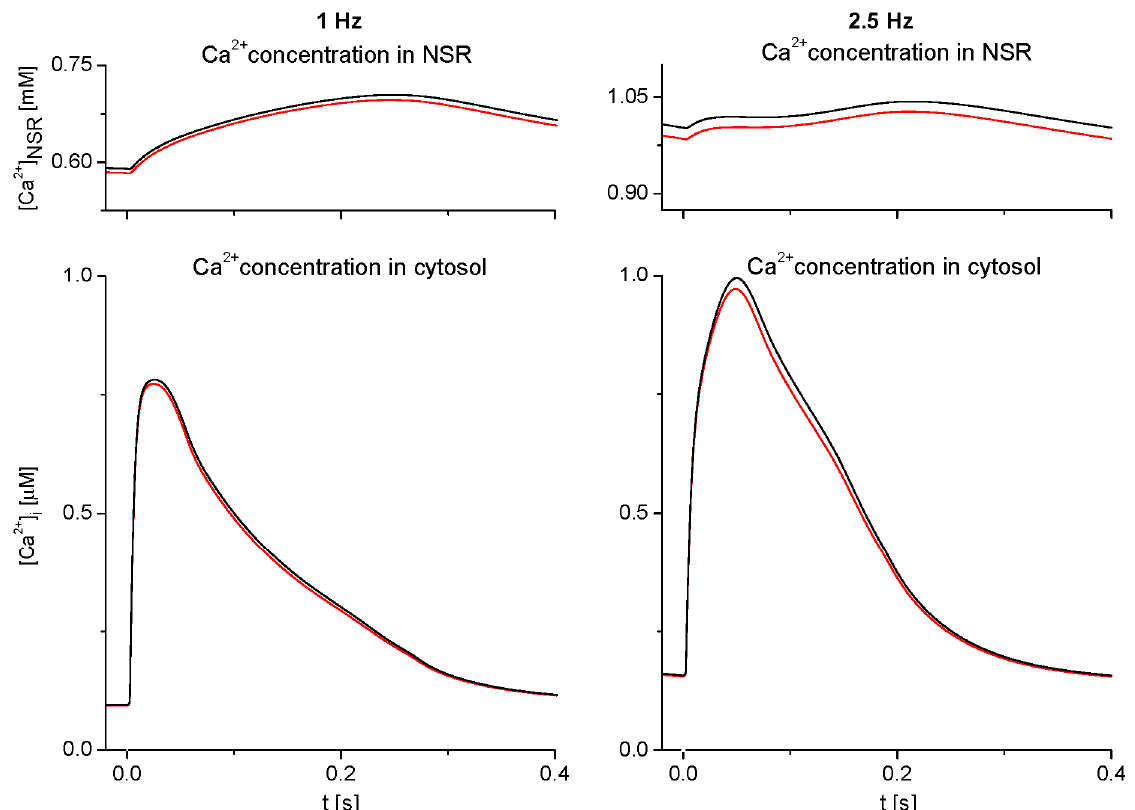
Figure 3. Effect of Ca 2+ and K + concentration changes in the first t-tubular segment and cleft space on Ca 2+ concentration in the network compartment of SR ([Ca 2+ ] Ca 2+ -transient in the cytosol ([Ca 2+ ] and 2.5 Hz ( right panel ). The results hold for basic adjustment of tubular fractions of Ca 2+ transporters in the model cell ( f was run when ion concentration changes in extracellular spaces were either allowed to change (red lines) or fixed at external bulk levels (black